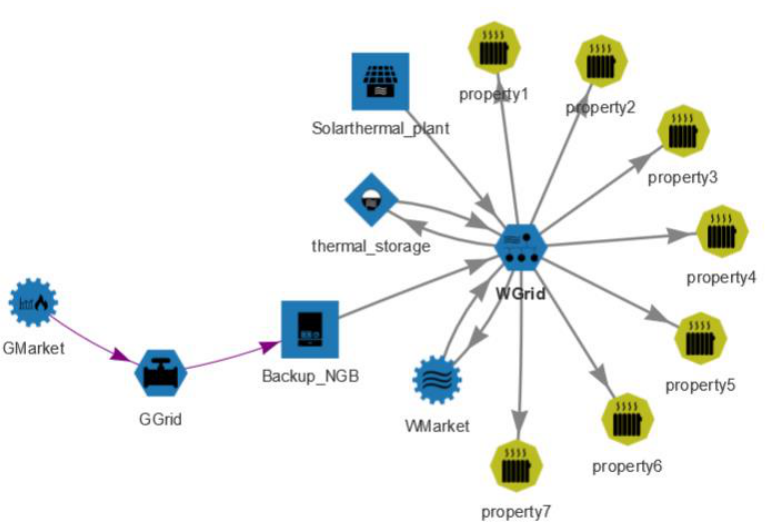
Figure 5. Model scheme of the demo district as visualized by IRPopt.